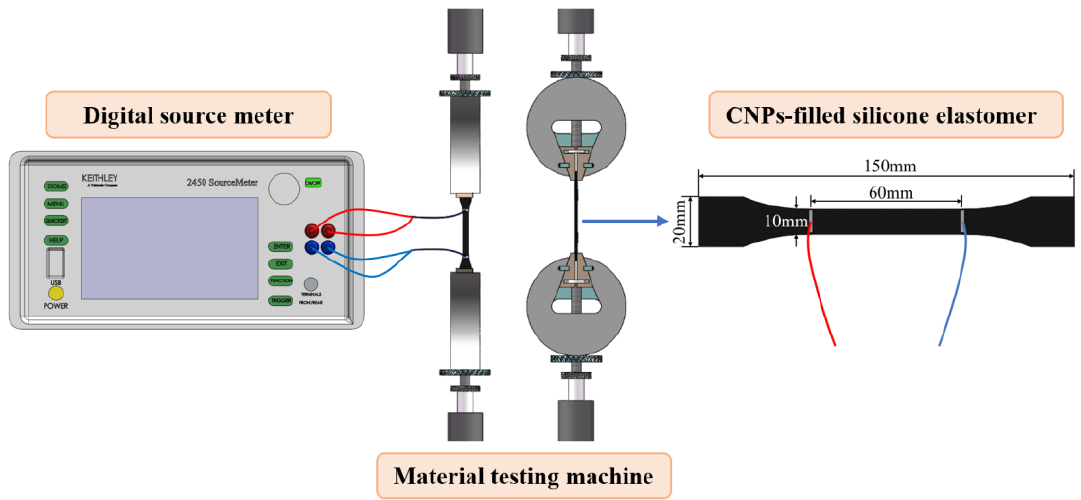
Figure 11. Schematic diagram of the test setup and specimen.